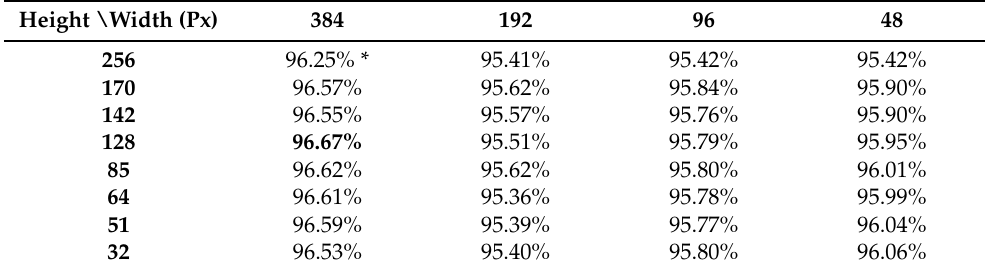
Table 3. Median accuracy calculated over 30 iterations on the test datasets for different LCO patch size configurations. Tested with patching method LCO without CC . (* at that patch size, only the SP was